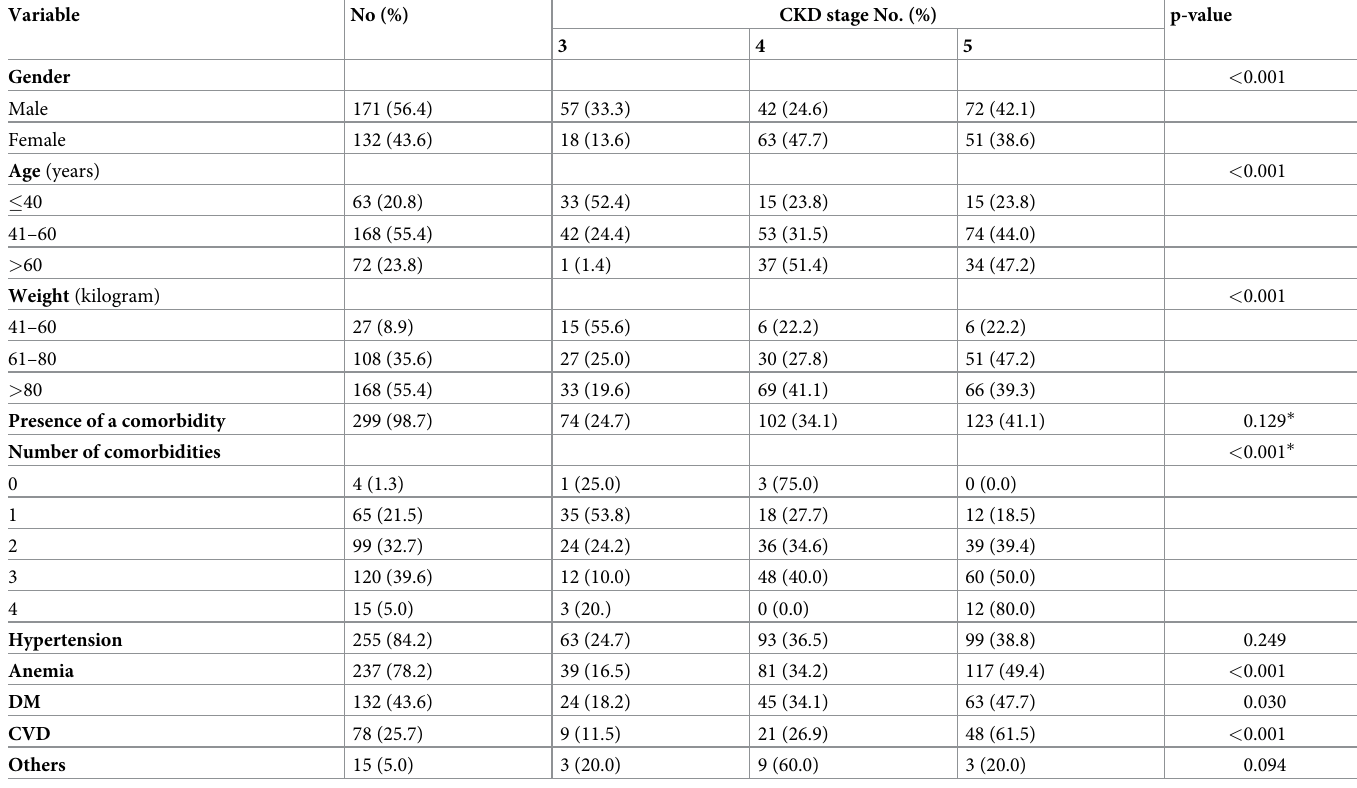
Table 2. Cross-tabulation between patients’ characteristics and CKD